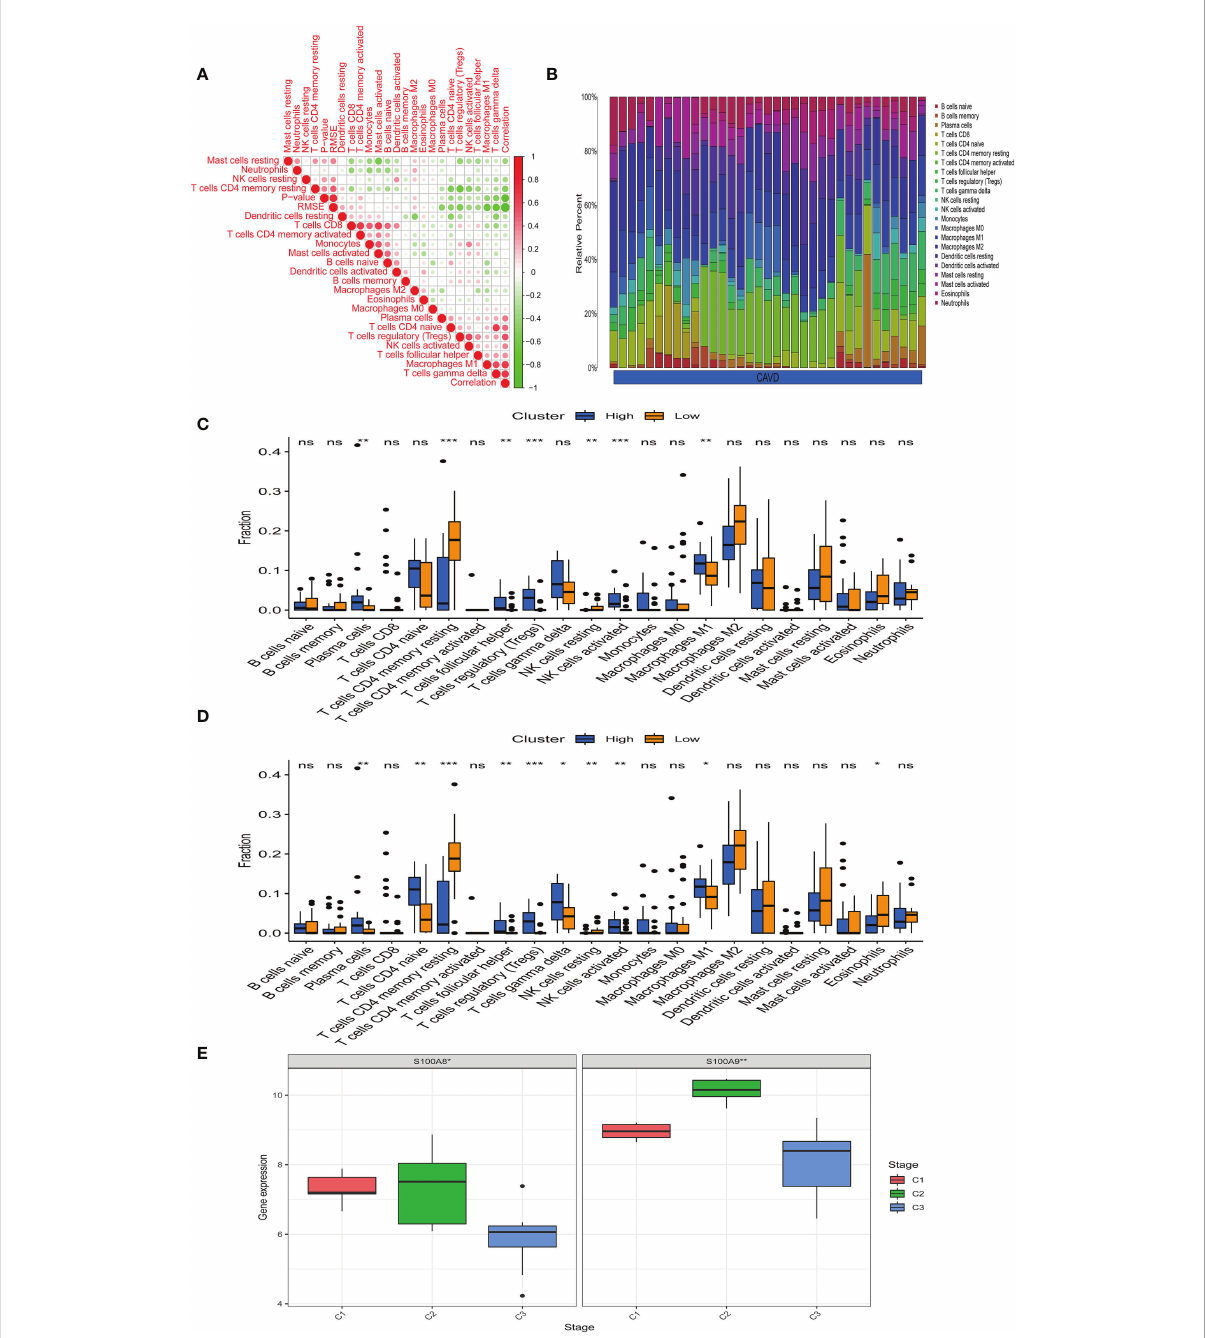
FIGURE 9 Immune in fi ltration analysis. (A) Correlation analysis of different immune cells. Darker green indicates a stronger negative correlation, and darker red shows the strongest positive correlation. (B) The immune landscape of calci fi c aortic valve disease (CAVD) revealed that the proportion of macrophages in the CAVD immune microenvironment was highest. (C) According to the expression of S100A8, patients were divided into a high- and low-expression groups. The in fi ltration levels of some immune cells (plasma cells, resting CD4 memory T cells, etc.) were different between the two groups. (D) According to the expression of S100A9, patients were divided into high- and low-expression groups. The in fi ltration level of some immune cells (plasma cells, CD4 native T cells, etc.) was different between the two groups. (E) Expression of S100A8 and S100A9 in immune subtypes. S100A8 and S100A9 tended to be highly expressed in the C2 immune subtype, and the difference was statistically signi fi cant ( P < 0.05). * P < 0.05, ** P < 0.01, *** P < 0.001 when two groups were compared as indicated or compared with the corresponding control. Ns indicates non-signi fi